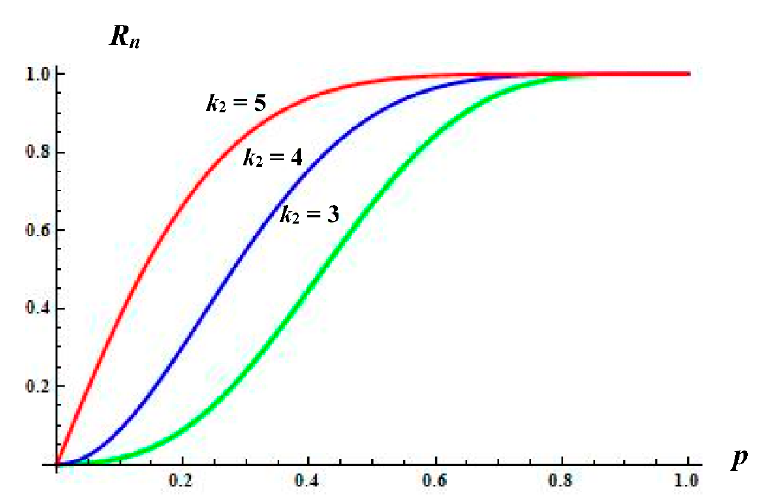
Figure 1. The reliability polynomial of the linear consecutive-2 and k 2 -out-of-8 systems ( k 2 = 3,4,5).